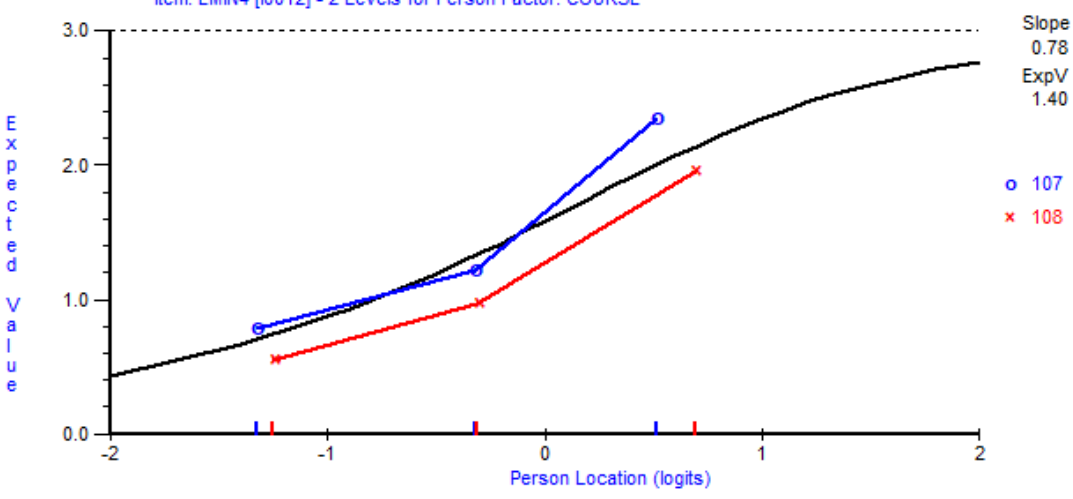
Figure 6. EMIN4 rs item characteristic curve displaying uniform DIF.